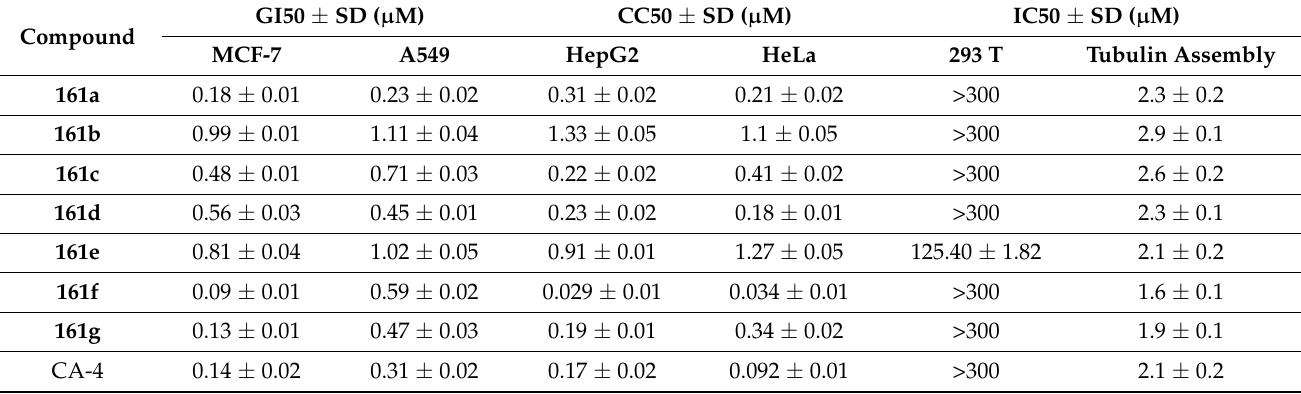
Table 9. IC50 ( µ M) values of active hybrids ( 161a – 161g ) against sensitive cancer cell lines and tubulin